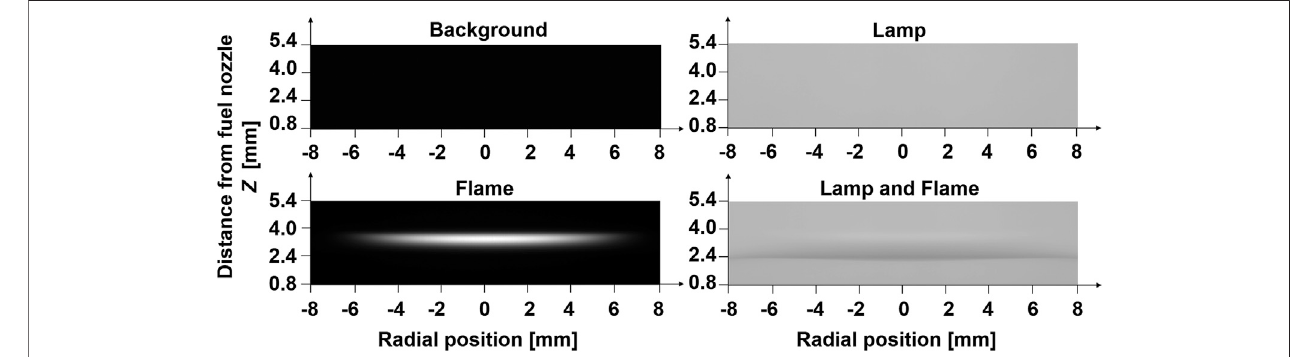
FIGURE 3 | Four types of images corresponding to measurement progress.